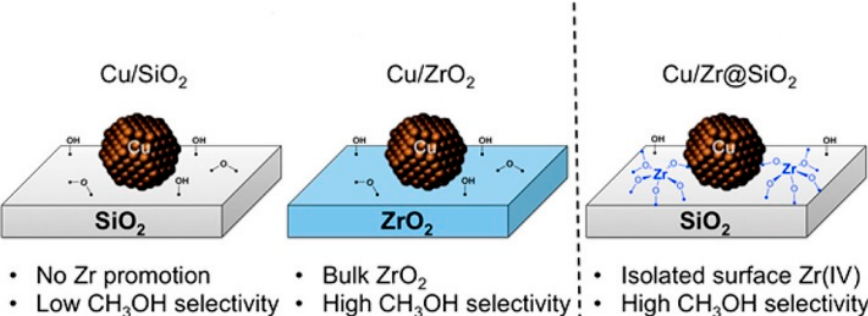
Figure 4. Experimental approach adopted by Tada and co-workers to understand the role of ZrO 2 in CO 2 hydrogenation [30] (https: // pubs.acs.org / doi / 10.1021 / jacs.8b05595). Reprinted with the CO 2 hydrogenation [30] (https://pubs.acs.org/doi/10.1021/jacs.8b05595). Reprinted with the permission of the American Chemical Society, further permissions related to the material excerpted